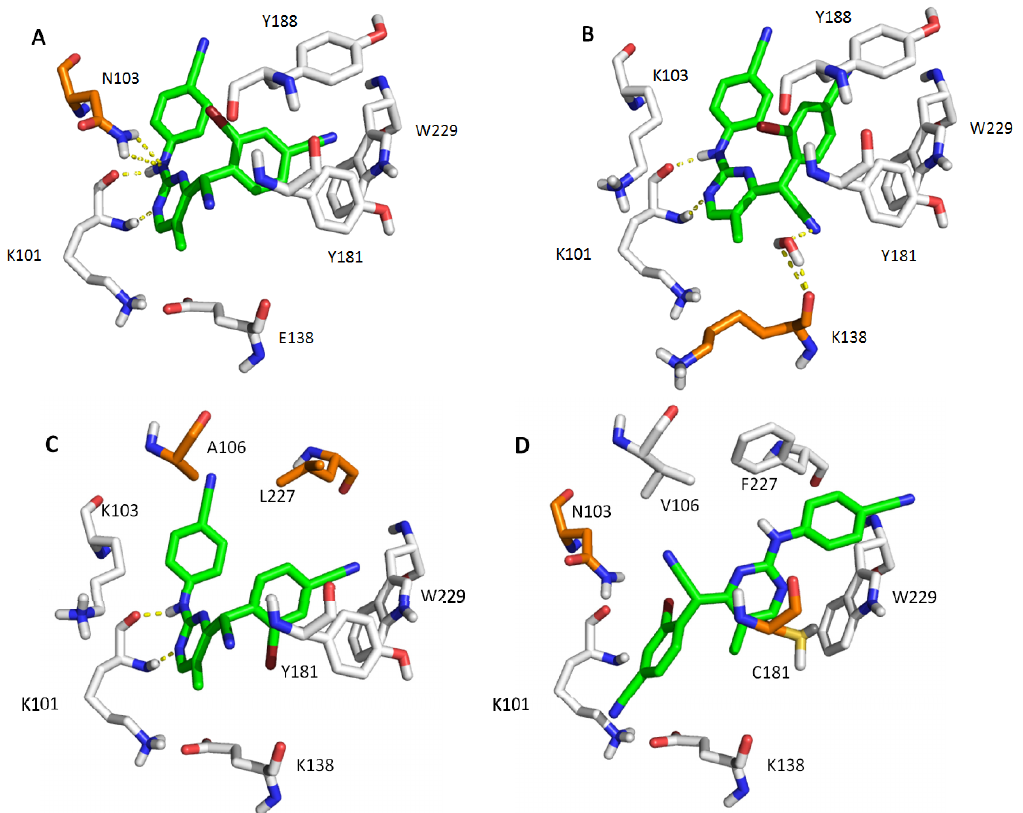
Figure 5. ( A ) Predicted binding modes of compound B4 with K103N. ( B ) Predicted binding modes of compound B4 with E138K (PDB: 2ZD1). ( C ) Predicted binding modes of compound B4 with F227L + V106A. ( D ) Predicted binding modes of compound B4 with K103N + Y181C. Mutated residues are depicted as orange sticks. The carbons of the compounds are depicted in green. Residues involved in interactions are shown as gray sticks. Hydrogen bonds are depicted as yellow dashed lines.